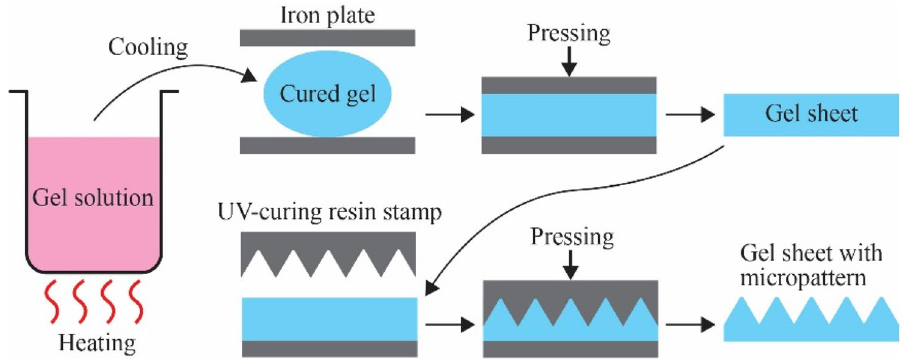
Figure 5. Fabrication process of the PVC gel sheets with